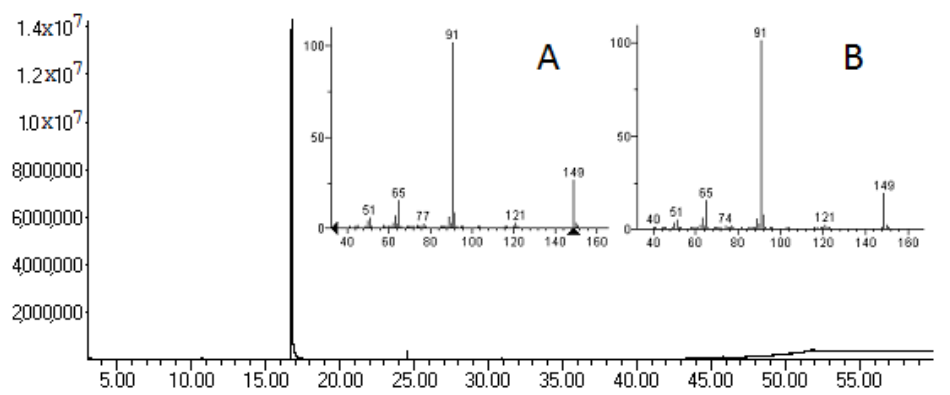
Figure 1. GC-MS chromatogram from the essential oil (EO) of T. pentaphyllum tubers, with mass spectra of benzyl isothiocyanate (BITC) standard from National Institute of Standards and Technology (NIST) library ( A ) and from peak with retention time of 16.76 min ( B ).